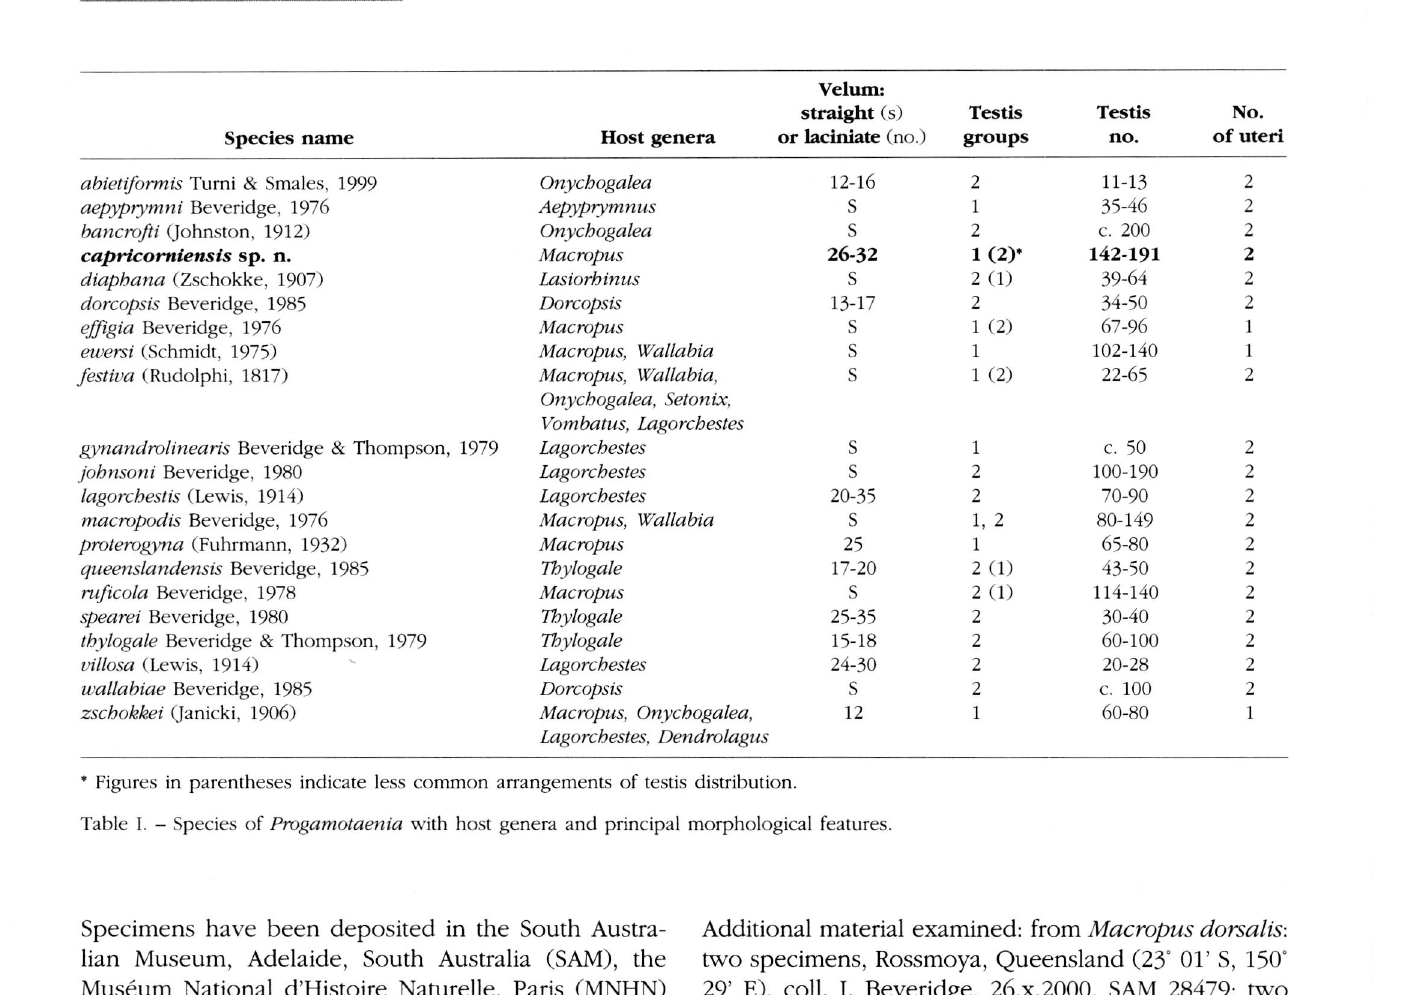
* Figures in parentheses indicate less common arrangements of testis distribution. Table I. - Species of Progamotaenia with host genera and principal morphological features.